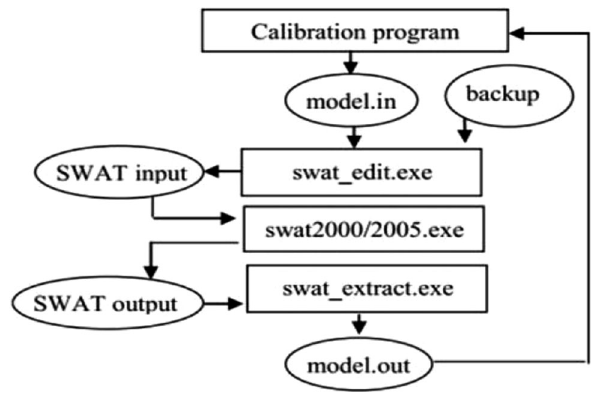
Fig. 2 The interaction between calibration program and SWAT in SWAT-CUP (Abbaspour et